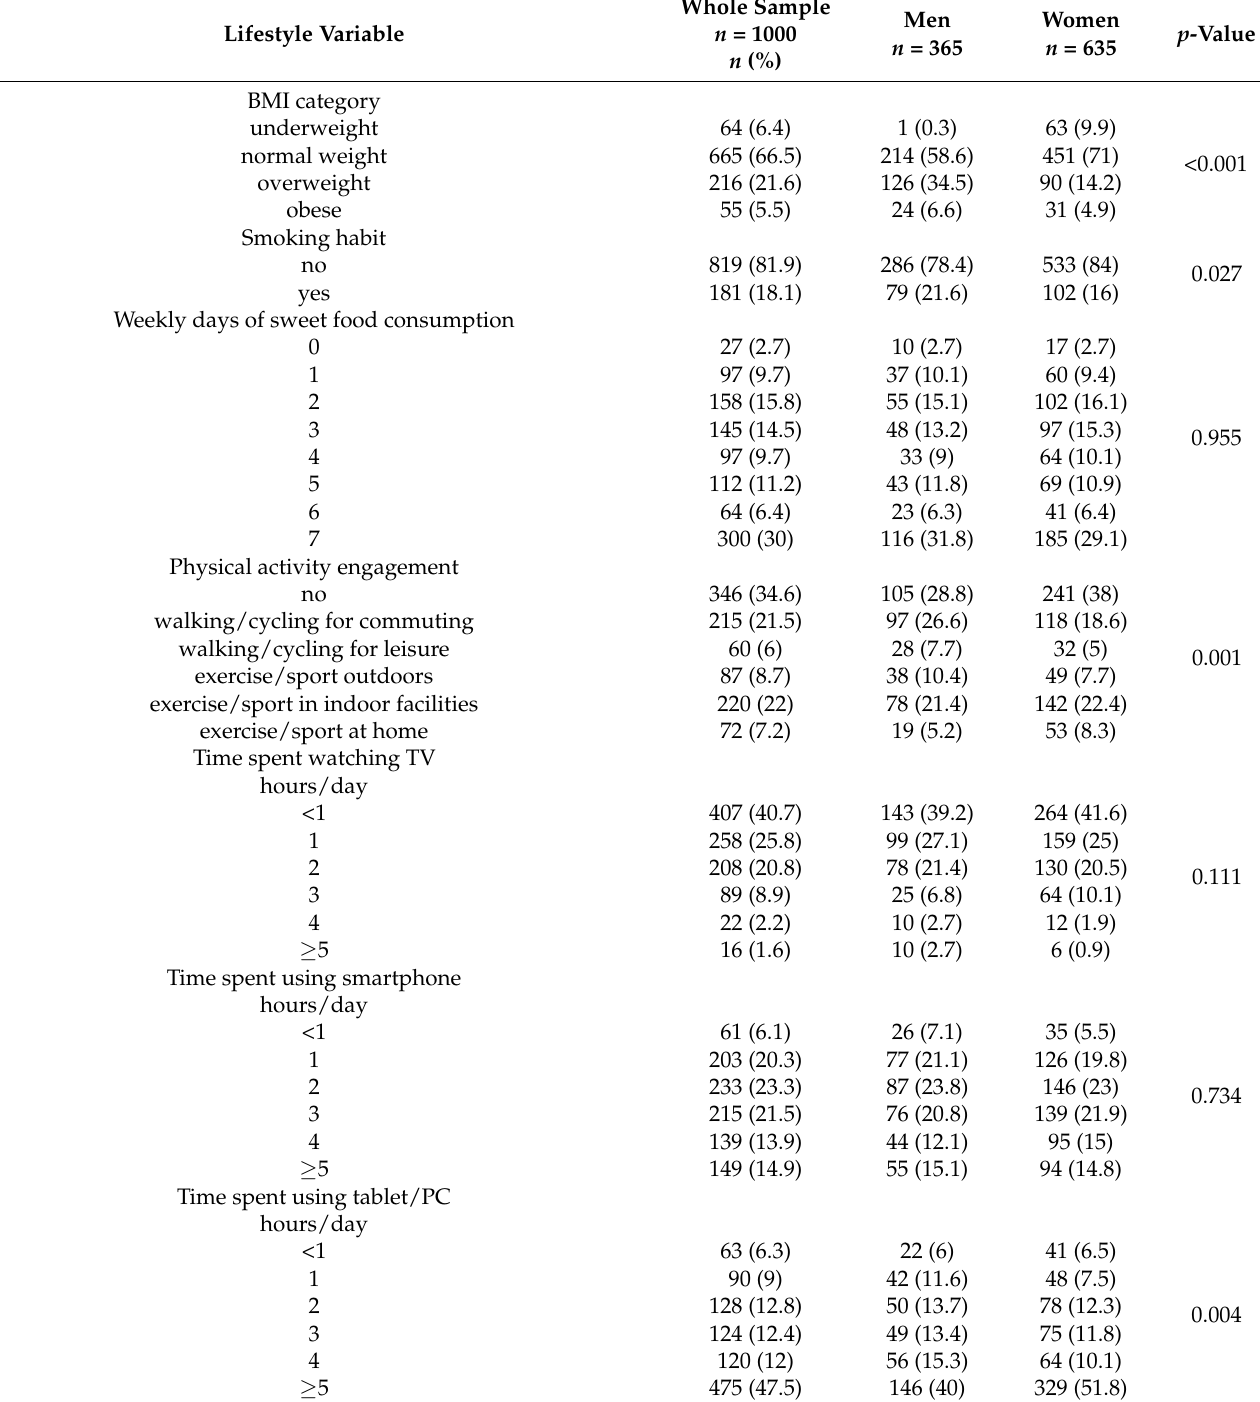
Table 2. Current health-related conditions and behaviors for the total sample and grouped by